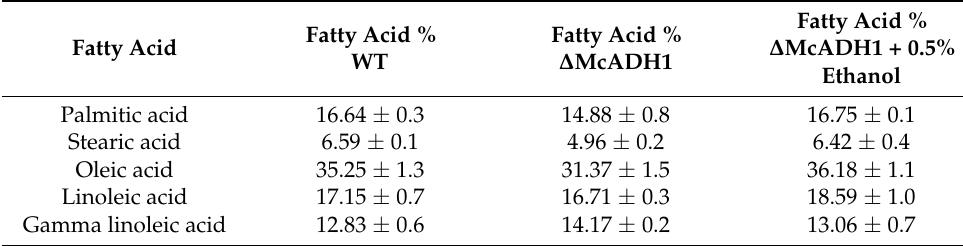
Table 1. Fatty acid profile of Wild type (WT), Knockout strain ( ∆ McADH1), and ∆ McADH1 + 0.5% ethanol in fed-batch culture.